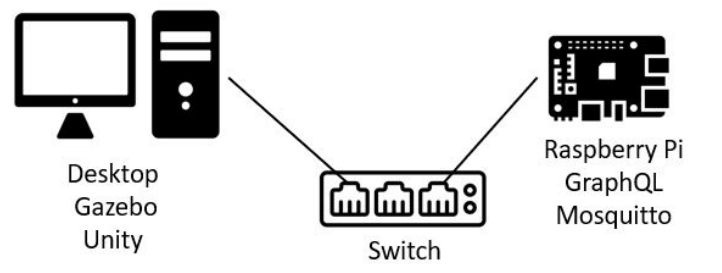
Figure 7. The measurement setup for the responsiveness test.